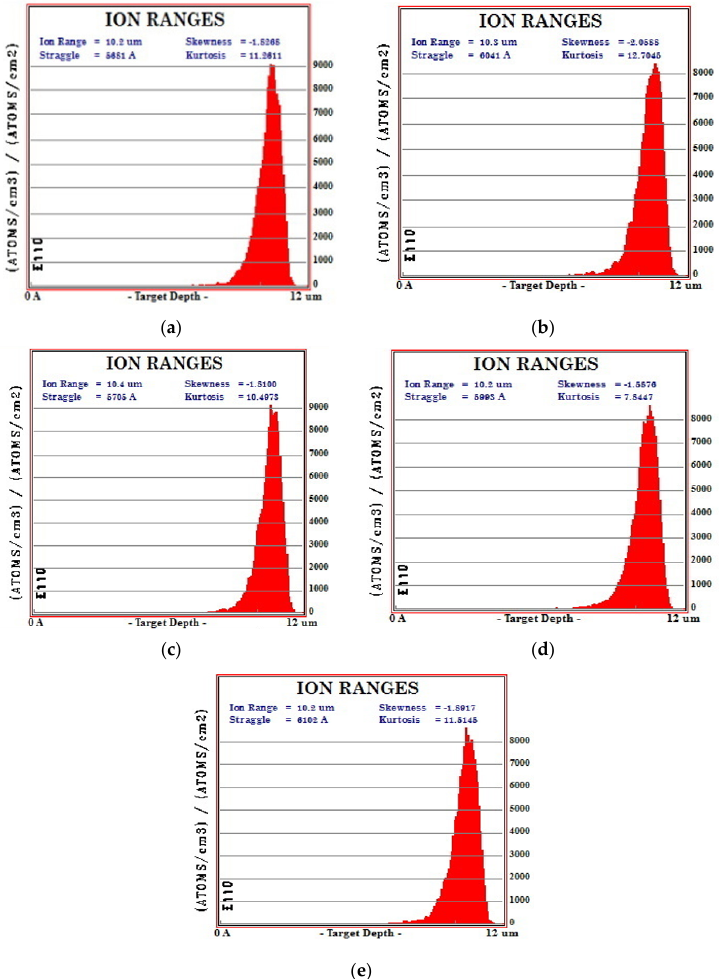
Figure 1. Ion ranges for the Fission Products (FPs): ( a ) Technetium (Tc); ( b ) Ruthenium (Ru); ( c ) Molybdenum (Mo); ( d ) Rhodium (Rh); and ( e ) Palladium (Pd), in E110 alloy, with recoil energy 120 MeV, corresponds to the maximum expected releasing energy for these fragments from the fission of Uranium −